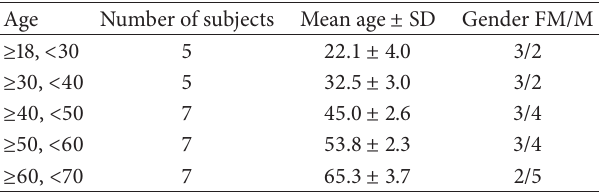
Table 1: Age and gender of the